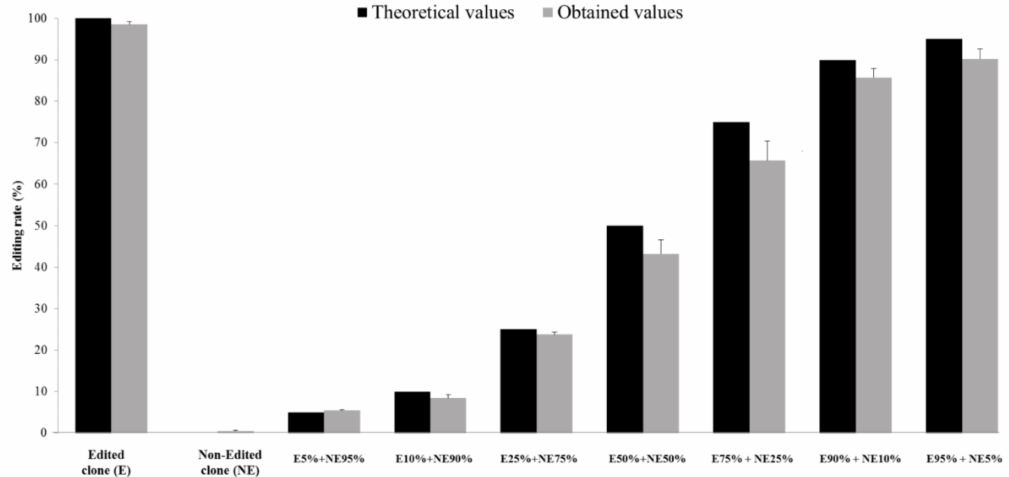
Figure 1. Validation of the editing rate quantification assay. Edited and non-edited clones were generated from an HDV-1 strain. The two clones were mixed in different proportions (see ‘Methods’ section) and analyzed. The expected values (in black) were compared to the observed values (in gray). The standard deviation was calculated from 8 values obtained for each